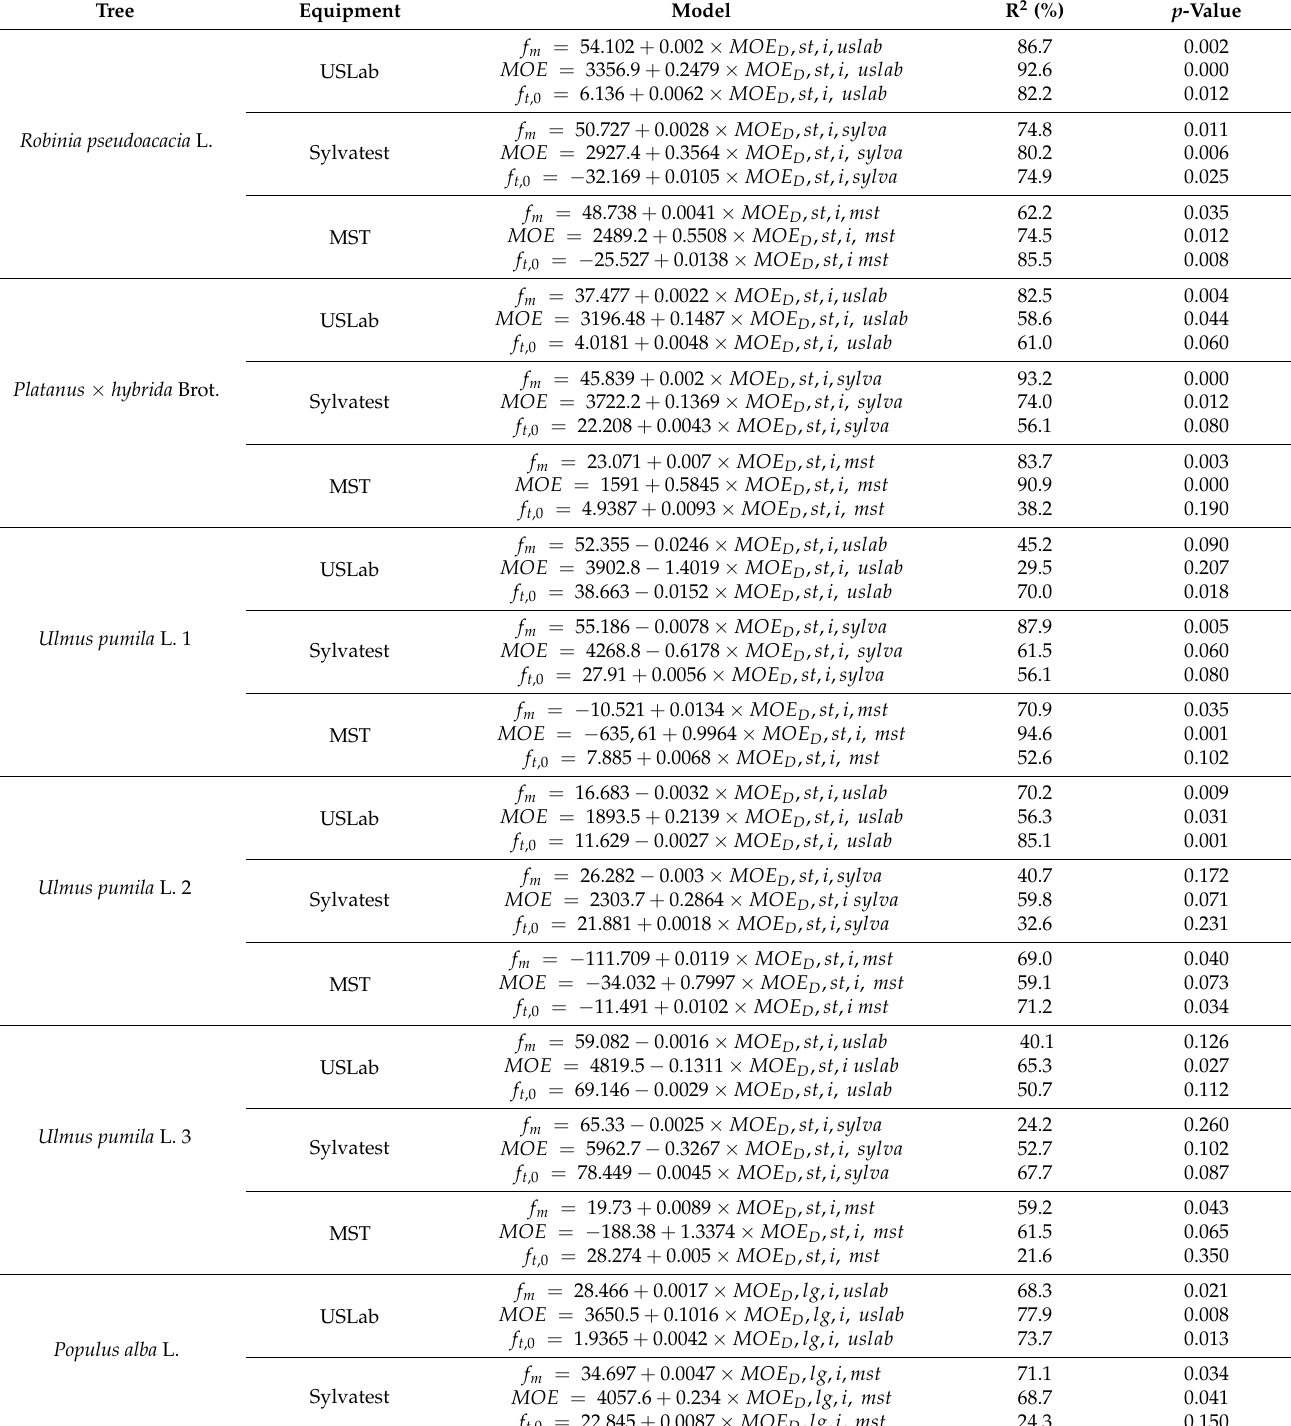
Table 7. Linear regressions between mechanical properties in saturated specimens and indirect MOE D in standing